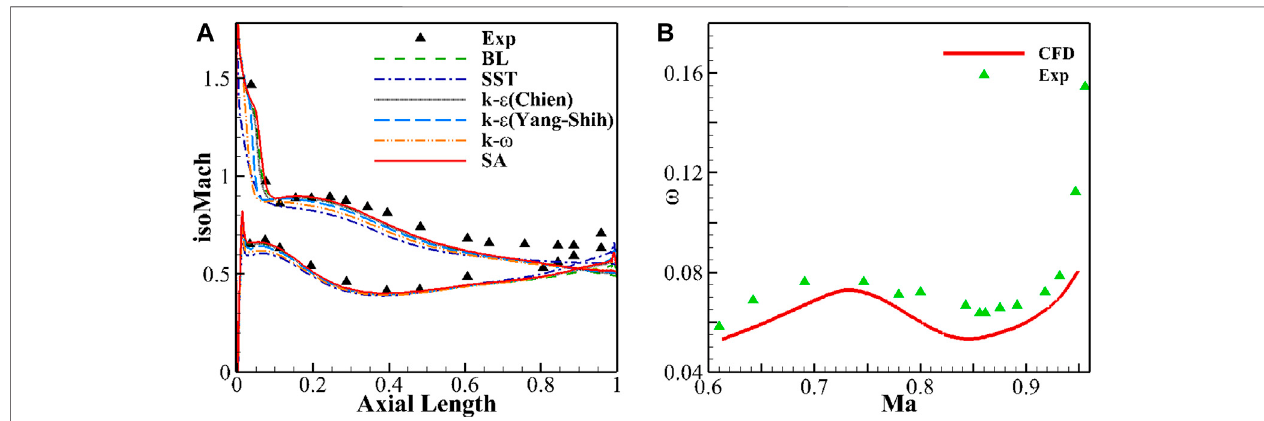
FIGURE6| Comparison ofnumerical and experimental results (A) IsentropicMach distribution ofblade surface; (B) Totalpressureloss versusinlet Machnumber.